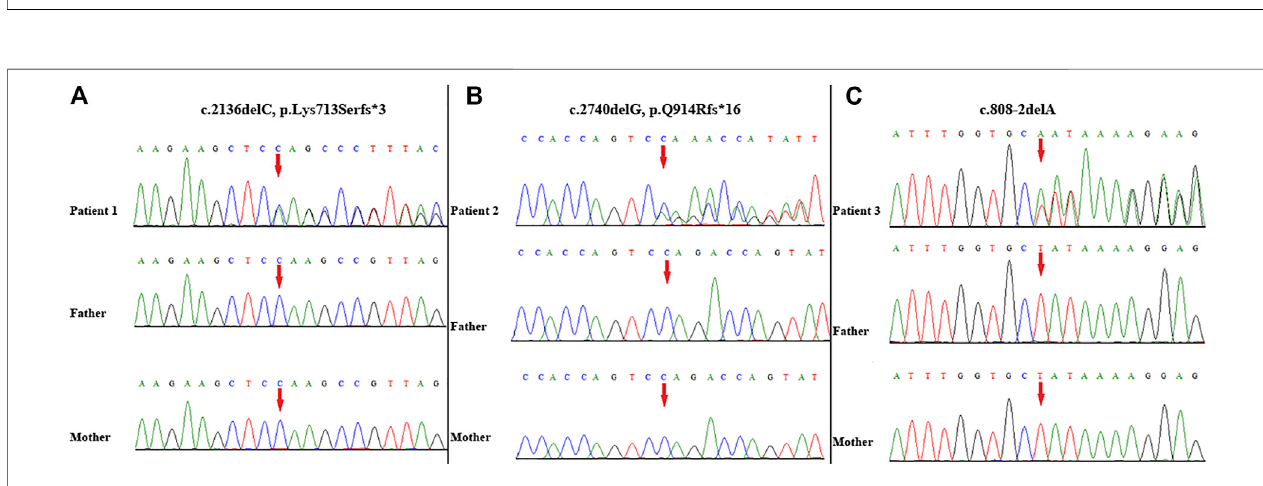
FIGURE 2 | Variant identi fi cation by Sanger sequencing. A de novo frameshift variant c. 2136delC, p. Lys713Serfs*3 in ZEB2 was detected in patient 1 (A) ; A de novo frameshiftvariantc.2740delG,p.Q914Rfs*16in ZEB2 wasdetectedinpatient2 (B) ;A denovo splicingvariantc.808-2delAin ZEB2 wasdetectedinpatient3 (C) . The red arrow indicates the variant